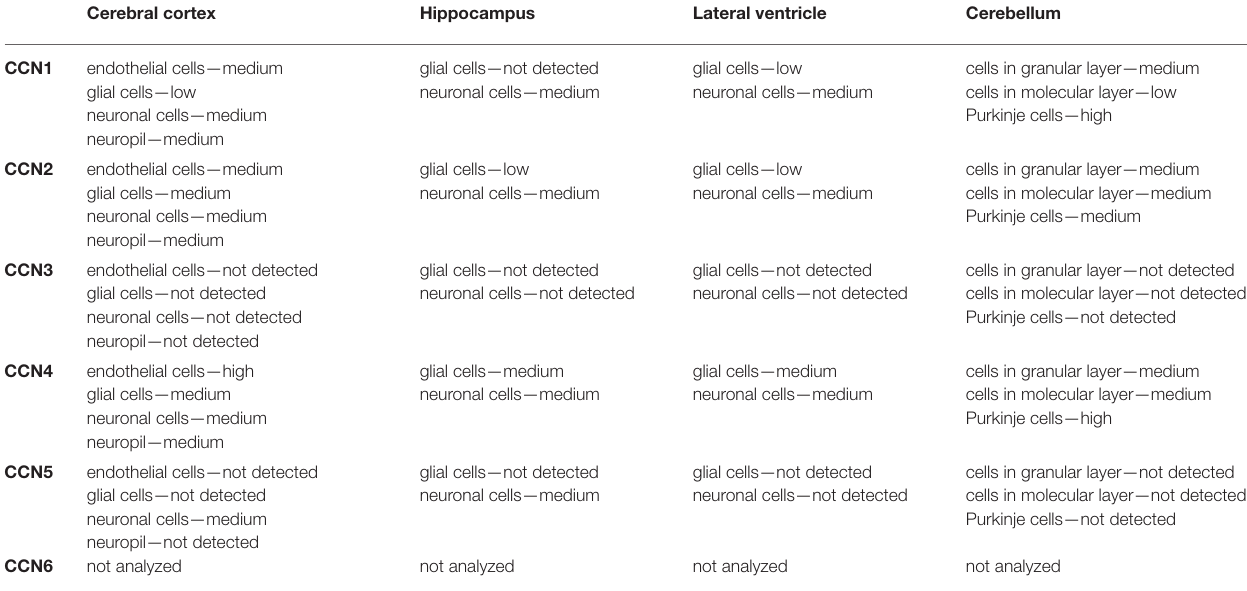
TABLE 3 | Cellular specificity of CCN protein expression in selected regions of the CNS according to the Human Protein Atlas . Cerebral